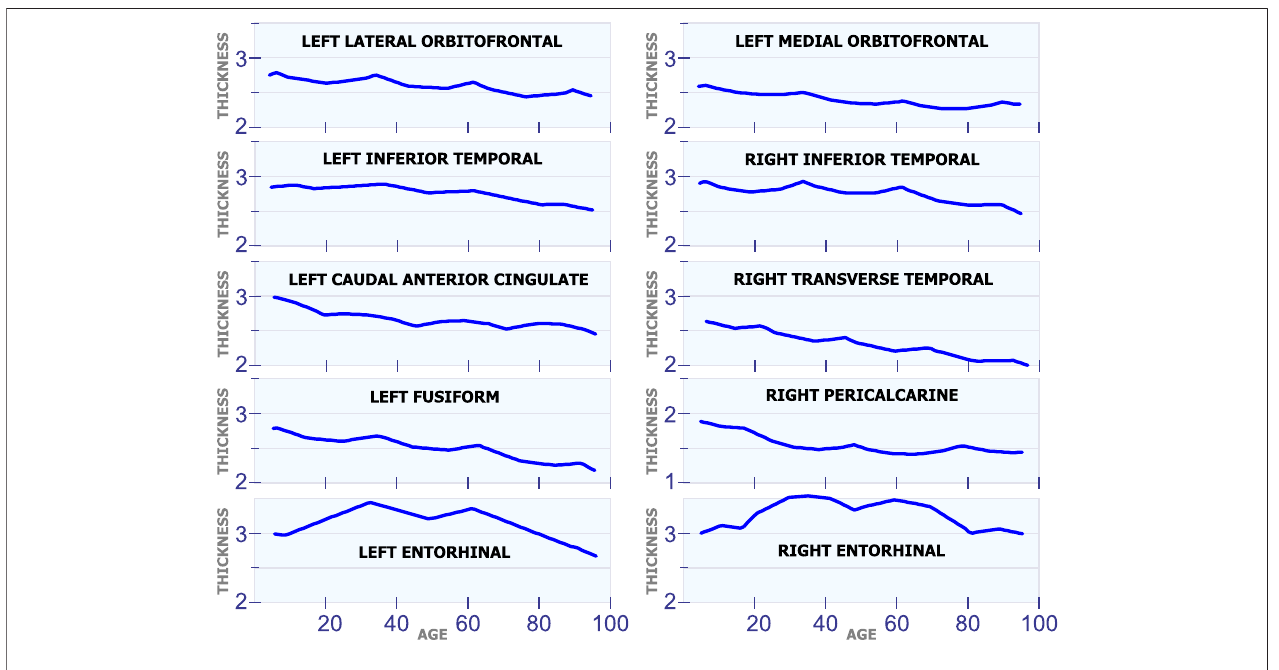
FIGURE 6 | Regions with multiple changes in cortical thickness through age.